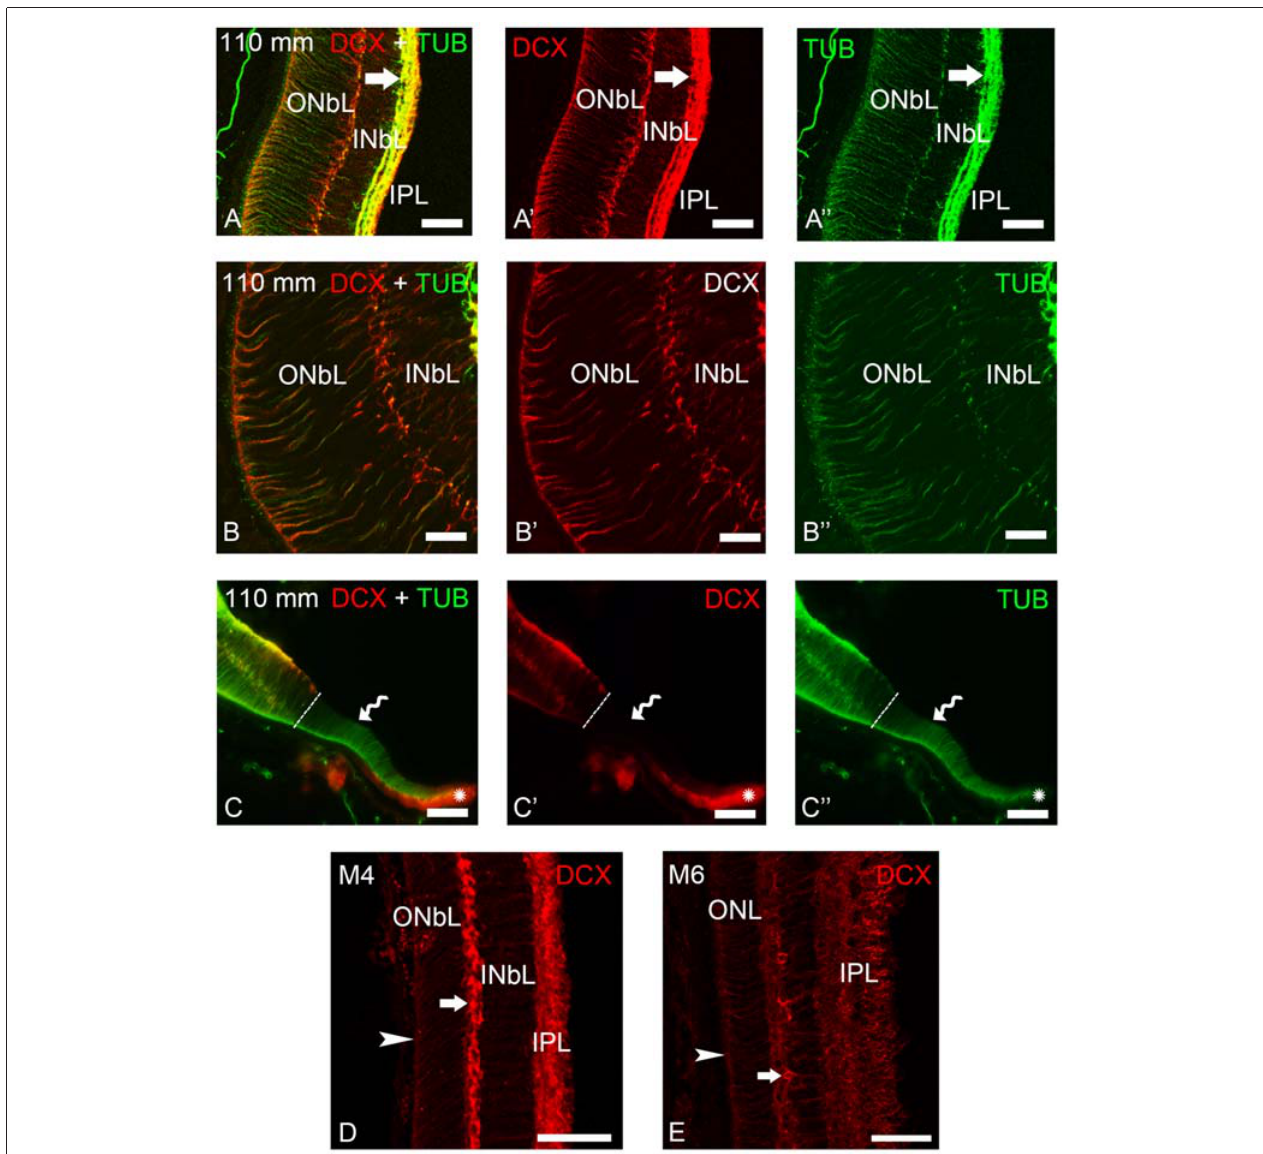
FIGURE 4 | Photomicrographs of transverse sections of the retina of premetamorphic and metamorphic larval sea lampreys showing anti-DCX and anti- α -tubulin immunoreactivities. (A–A”) DCX/ α -tubulin-ir double-labeled ganglion cells and fibers in the IPL and cells of the outer layer of the INbL in the lateral retina. Note the presence of double labeled radial fibers coursing throughout the neuroblastic layers and ending in the OLM. (B–B”) Detail of the lateral neural retina of a premetamorphic larva showing the presence of DCX/ α -tubulin-ir double-labeled radial fibers in the INbL and ONbL. (C–C”) Photomicrograph of the border of the lateral neural retina of a premetamorphic larva showing the lack of DCX immunoreactivity in the growing irideal retina (curved arrow). Note that the outer epithelium of the irideal marginal region was DCX-ir (asterisks). Dash lines limit the marginal retina from the rest of the lateral retina. (D) In M4 larvae, DCX immunoreactivity was observed in fibers in the IPL, in radial fibers of the INbL and ONbL ending in the OLM (arrowhead) and in cells in the outer INbL (arrow). (E) In M6 larvae, DCX immunoreactivity was similar but retinal layers appear differentiated. (A–C) : Overlay; ( A’–C’ ): DCX; ( A”–C”) : α -tubulin. Scale bars: 50 µ m (A–A”,C–C”) ; 37.5 µ m (D,E) ; 25 µ m (B–B”)